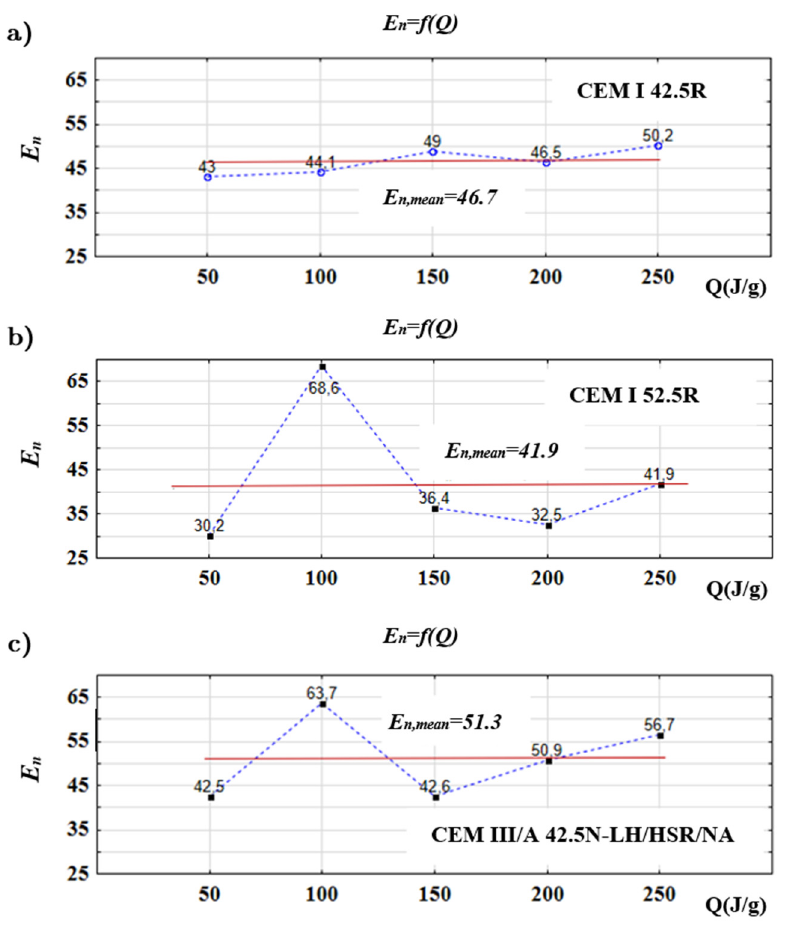
Figure 6. Values of the E n in relation to the total heat generated Q calculated for studied cements ( a ) CEM I 52.5 R, ( b ) CEM I 42.5 R, ( c ) CEM III A 42.5 N.